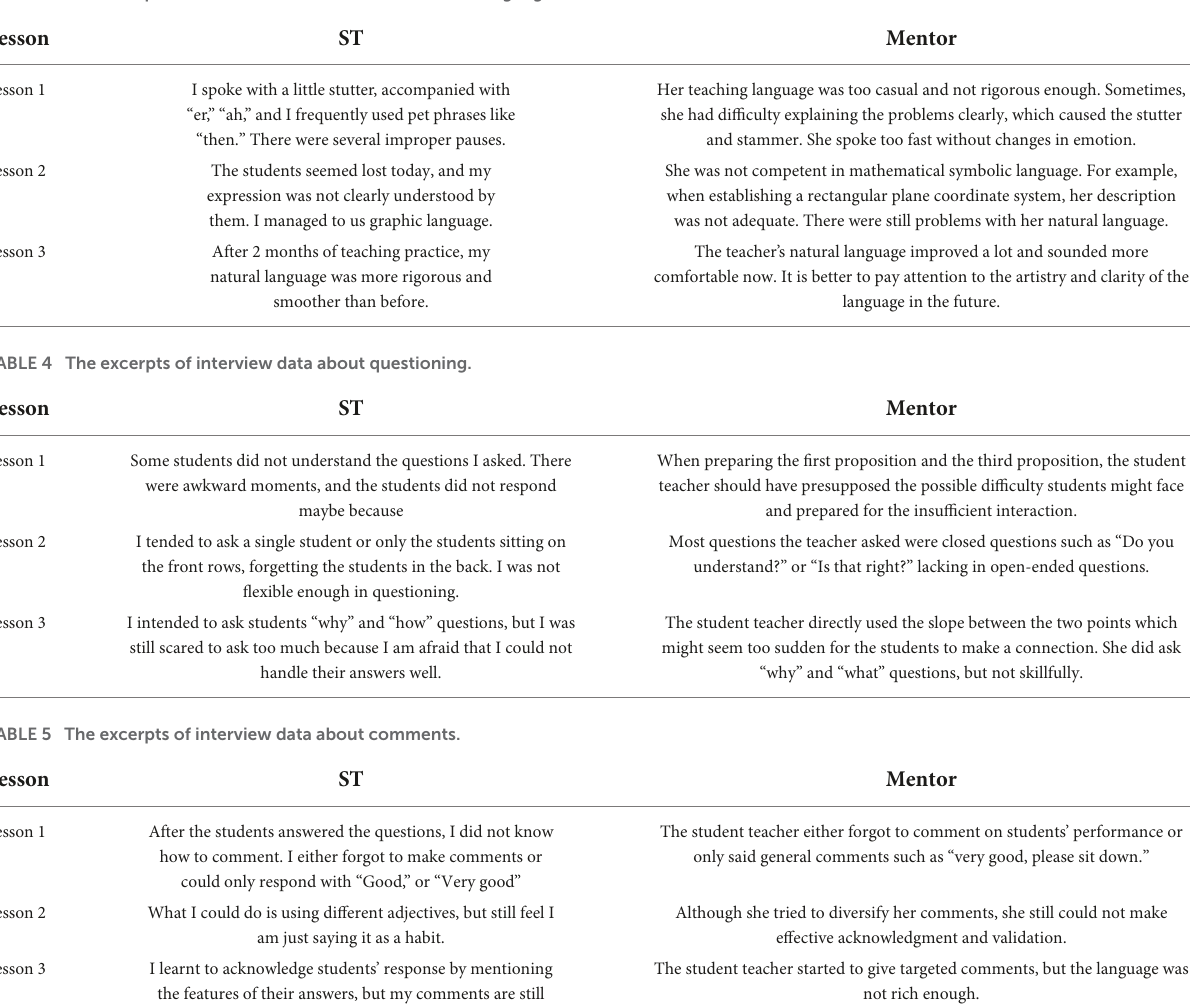
TABLE 3 The excerpts of interview data about instructional language.